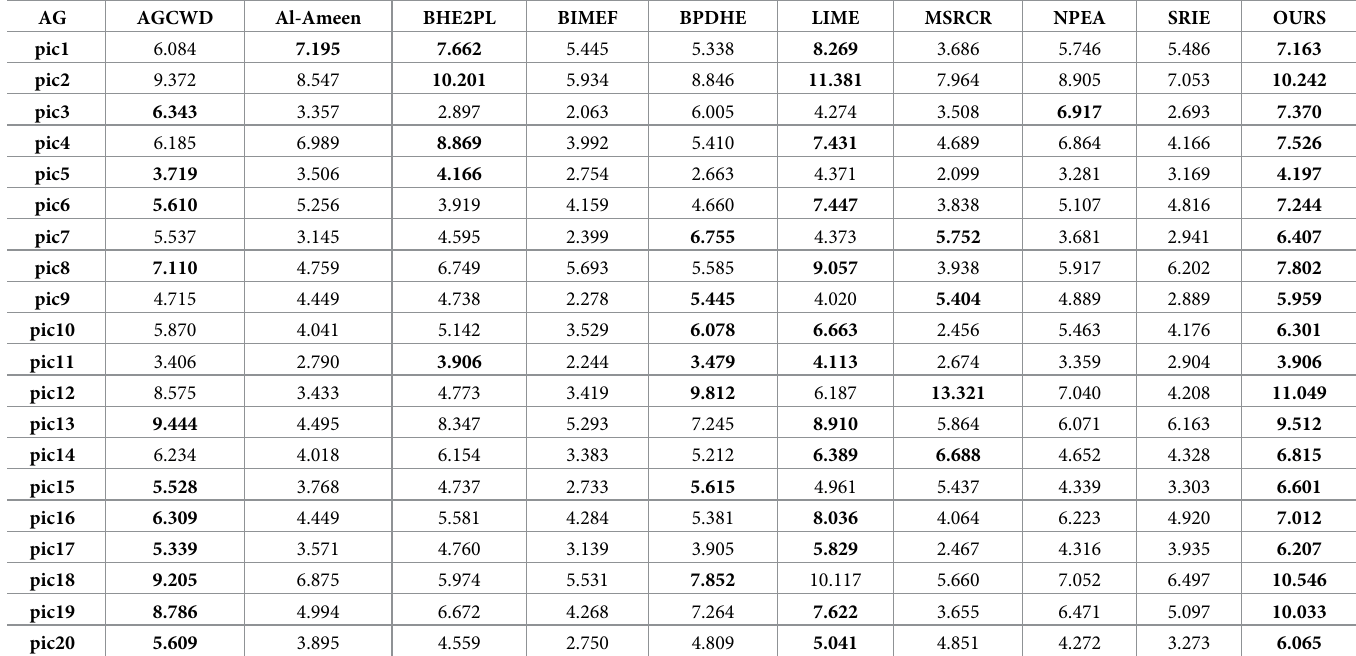
Table 9. Image average gradient values of 20 random images of MIT-5K.